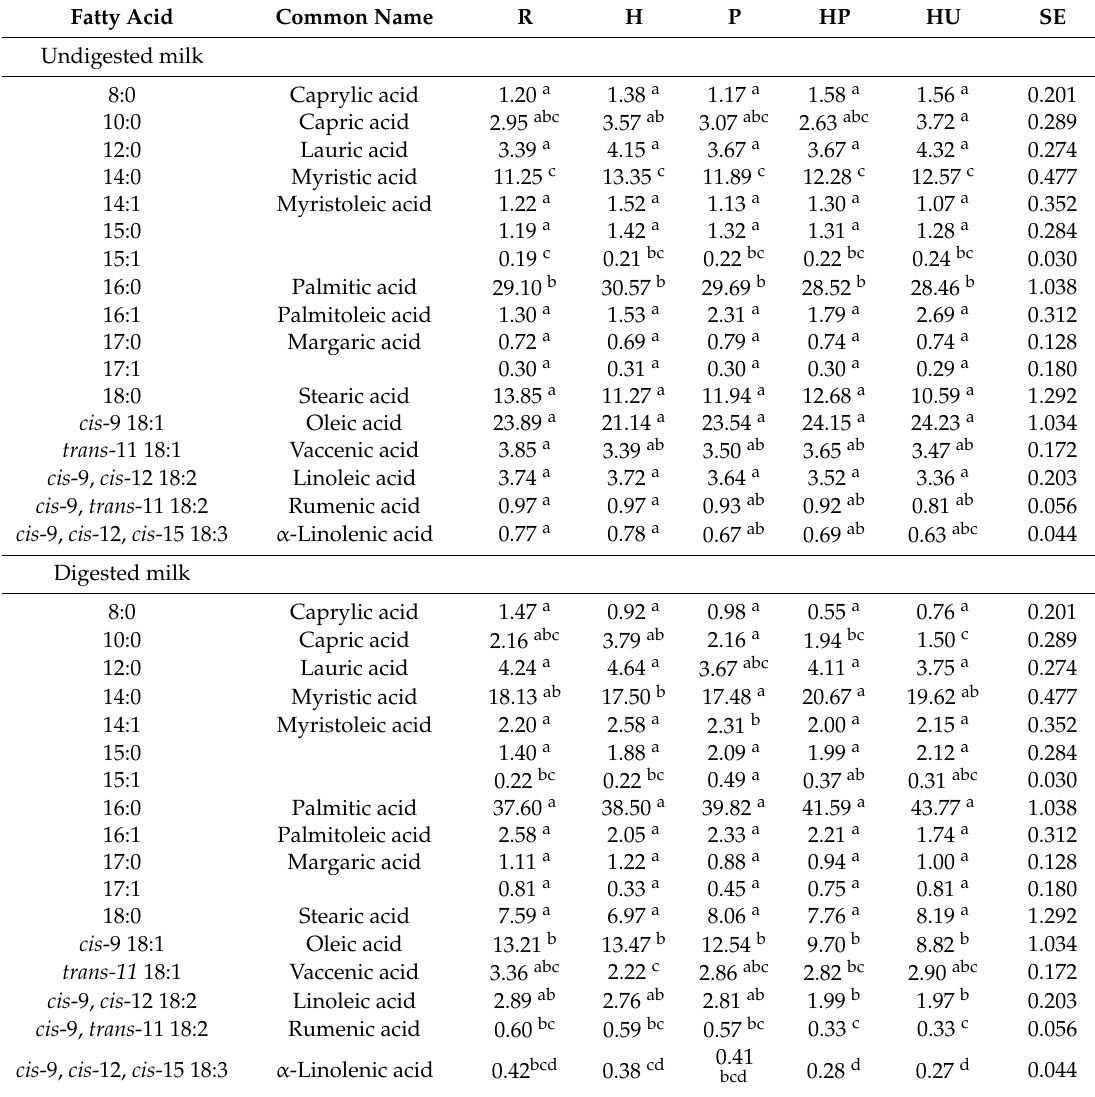
Table 1. Fatty acid concentrations (g/100 g) for differently processed milk before and after a 3 h gastro-intestinal